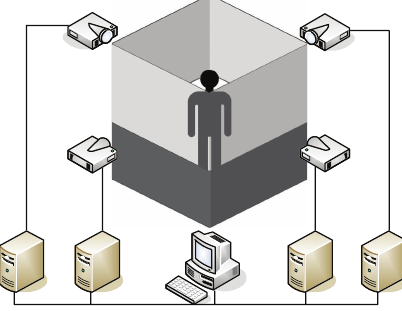
Figure 1: Schematic view of the